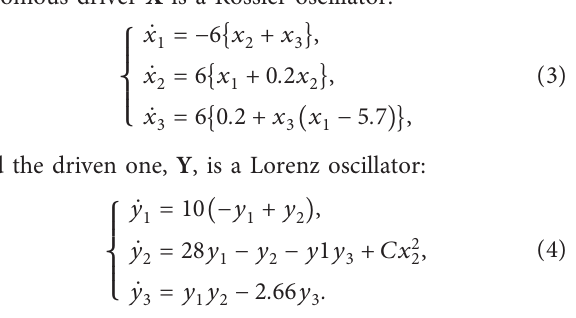
Figure 1: Estimated embedding dimensions for low-dimensional chaotic system. (a) First derivative of S [ M function of m at different time delays τ for a Lorenz dynamical system. Across all τ values, the derivative reaches zero for m � 4. (b) Estimated m for a set of chaotic systems. For comparison purposes, values are plotted as a function of correlation dimension d dynamical system, we show mean and standard error of the mean evaluated across N � 50 realizations. Dashed line corresponds to m � d + dotted line is m � 2 d 2